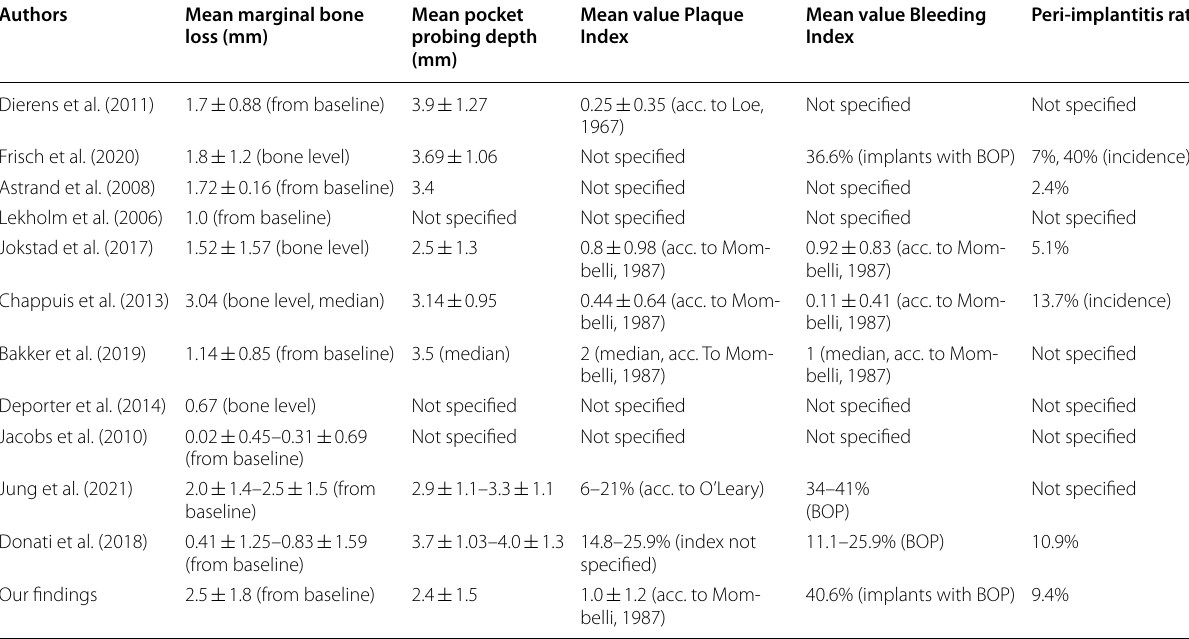
Table 6 Mean values for MBL, PPD, plaque, and Bleeding Index as well as the corresponding peri-implantitis rate, as described by the authors in Table